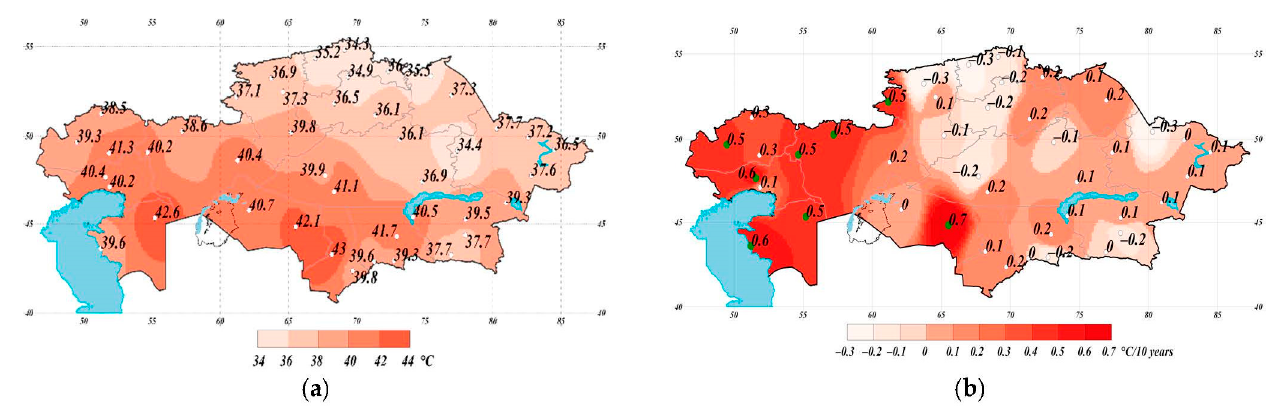
Figure 5. Spatial distribution of the index characterizing maximum monthly values of maximum daily air temperatures (TXx) ( a ) and trends ( b ) of this parameter for the period 1971–2020. In general, the trend of TXx index repeatability increase prevails; however, insignifi- cant and non-significant negative trends are observed in the northeastern and northern zones of Kazakhstan. Significant positive trends are observed only in western Kazakhstan and amount to 0.4–0.7 °C/10 years. The lowest monthly values of minimum daily air temperatures (TNn) in the territory of Kazakhstan are observed in the north and east of Kazakhstan (minus 35 ◦ C-minus 38.8 ◦ C) (Figure 6).